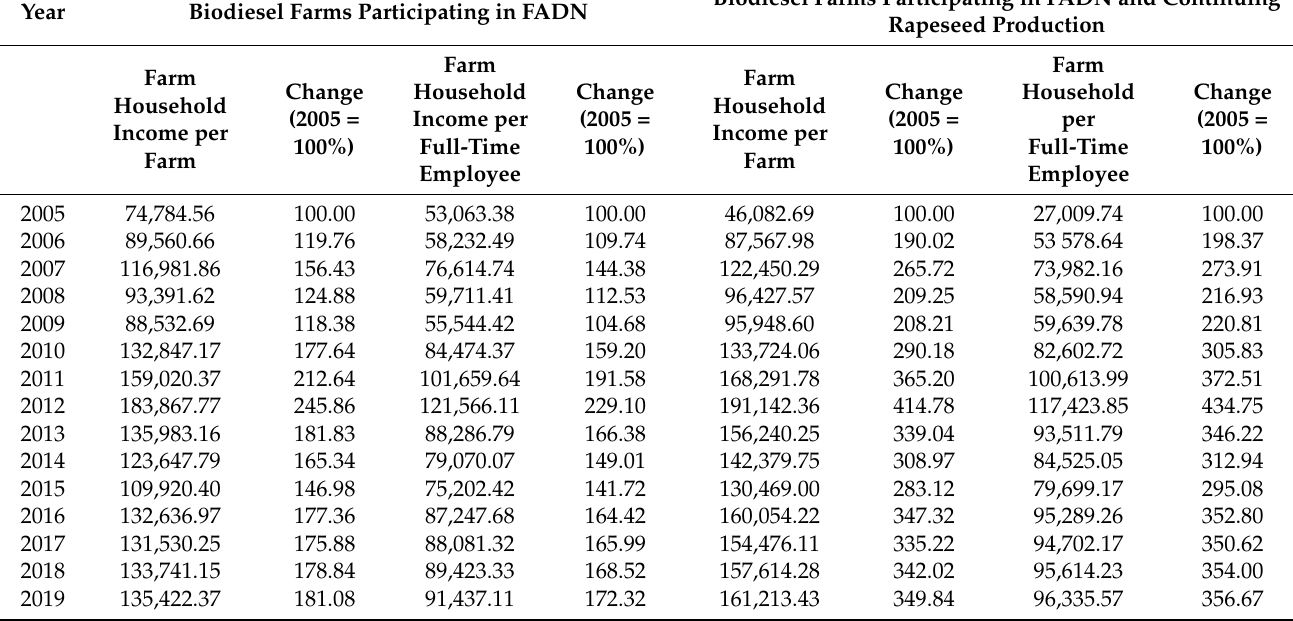
Table 8. Farm household income (PLN) per Polish biodiesel farm from 2005 to